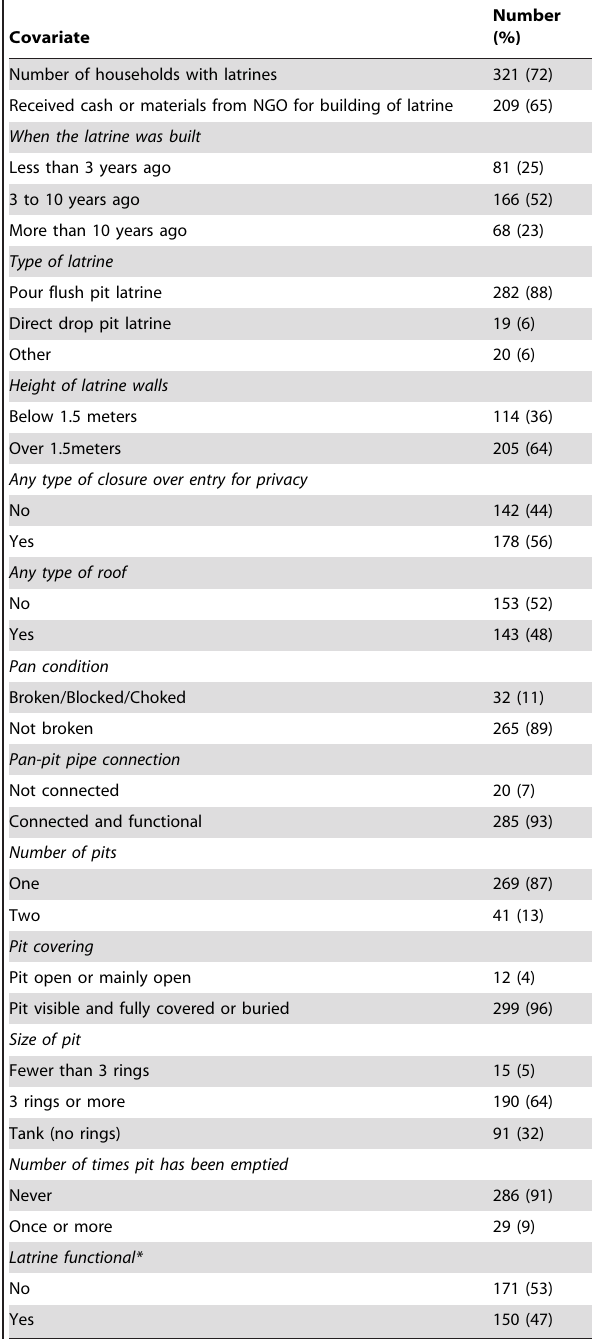
Table 2. Latrine